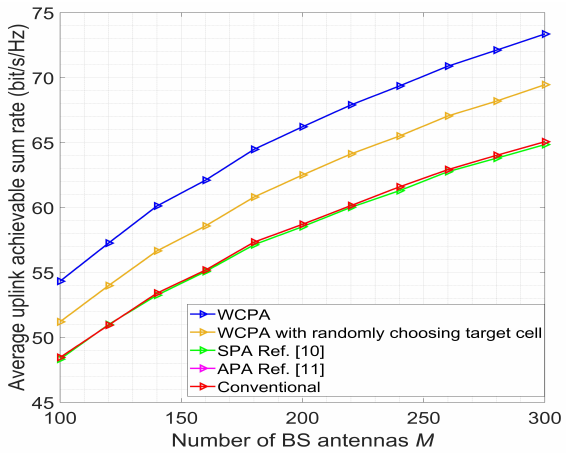
Figure 2. Average uplink achievable sum rate in case K = 8, S = 8.